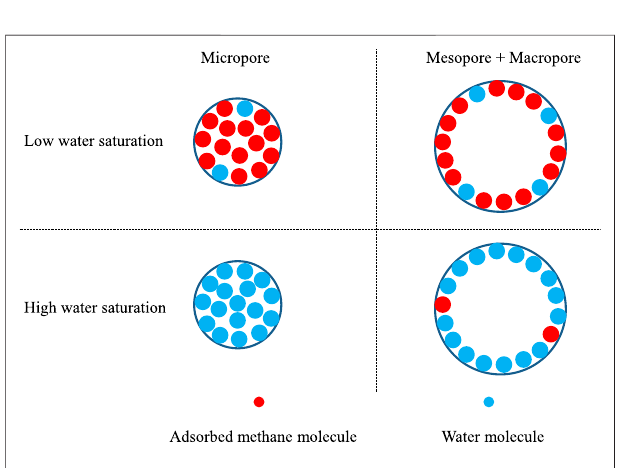
FIGURE 3 | Effect of pore water on methane adsorption at different water saturation